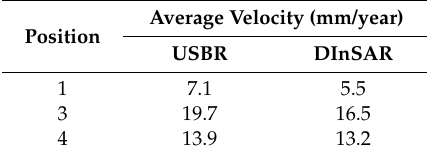
Table 4. DInSAR vs. extensometers.